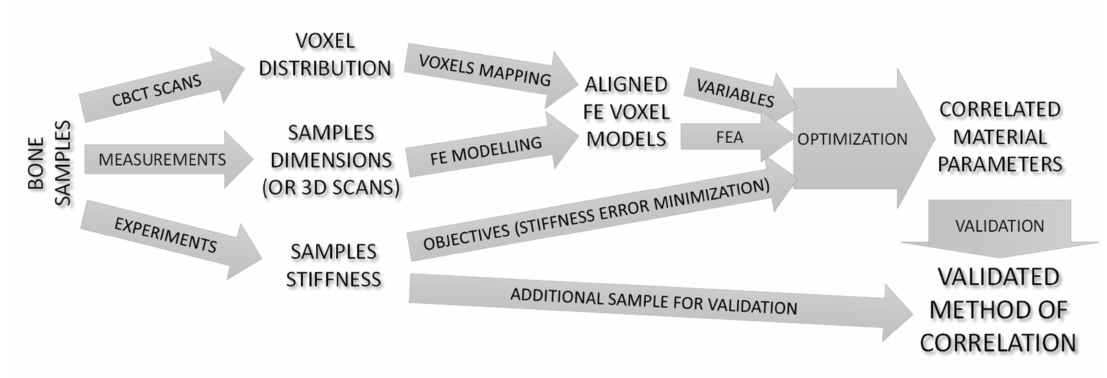
Figure 2. Workflow of the present